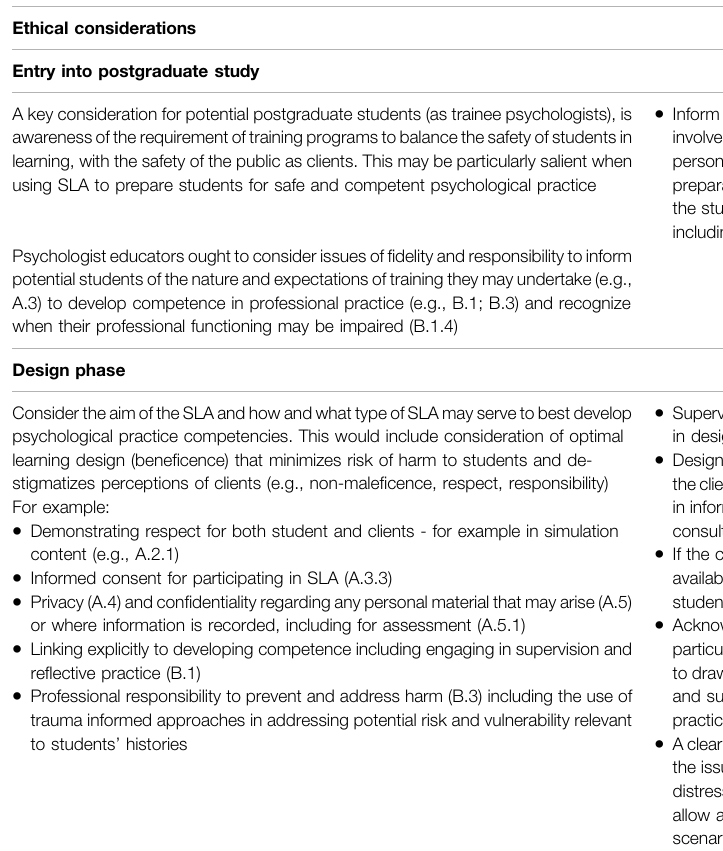
TABLE 2 | Ethical considerations and practical suggestions for employing ethical psychological practice principles at each phase of the